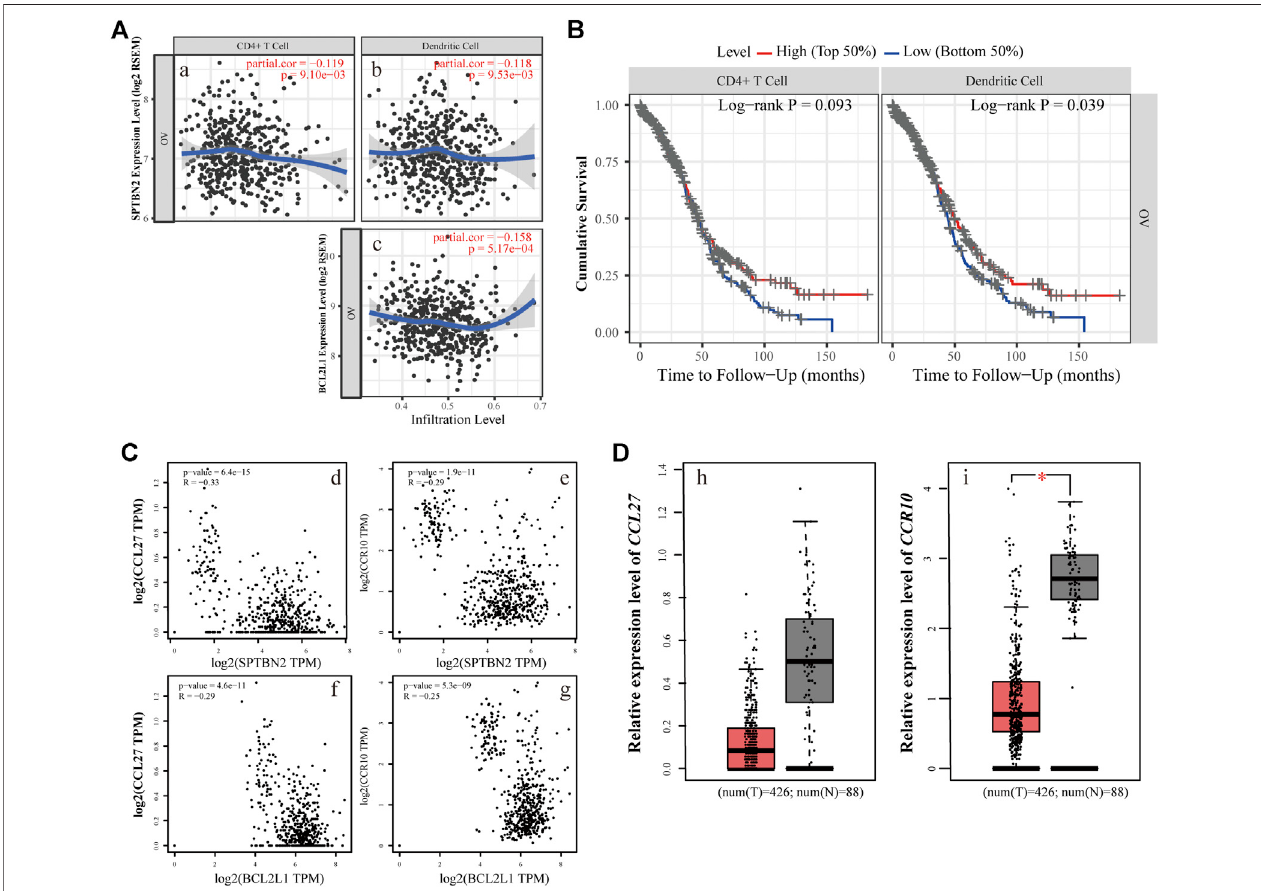
FIGURE 10 | Immunoregulatory relationship of the hub genes. (A) The relevance of the expression level and immunocyte in fi ltration, where SPTBN2 modulated CD4 + T cells (i) or dendritic cells (ii) and BCL2L1 regulated dendritic cells (iii) . (B) Cumulative survival difference among OV patients with high or low CD4 + T cells (left panel) and high or low dendritic cell in fi ltration (right panel) . (C) The correlation between chemokine family or receptors and the hub genes. The expression levels of CCL27 and CCR10 negatively correlated with SPTBN2 (i,ii) and BCL2L1 (iii,iv) , respectively. (D) Differential gene expression of CCL27 (i) and CCR10 (ii) with 426 OV samples vs. 88 NC